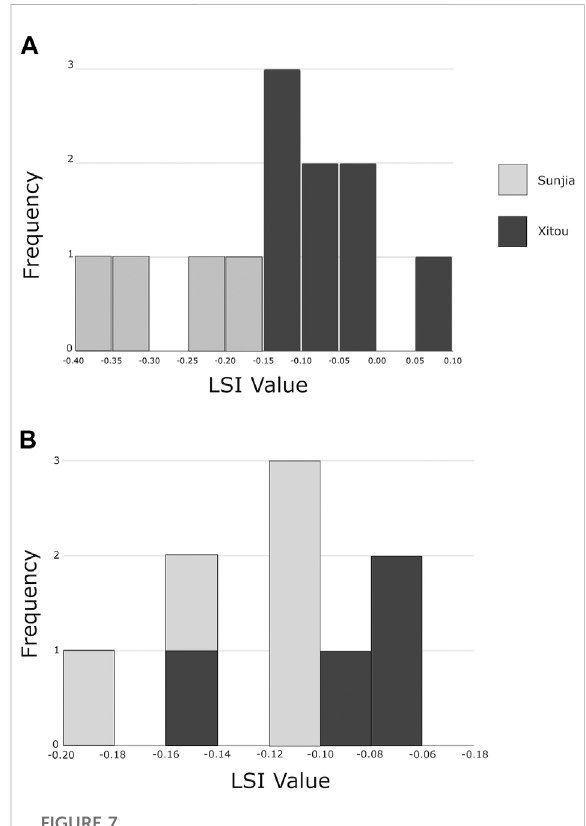
FIGURE 7 Distribution of LSI values for cattle (A) and pigs (B) ’ elements in Sunjia and Xitou. Standard animal data from Degerbol and Fredskild (1970) and Russel (1993),